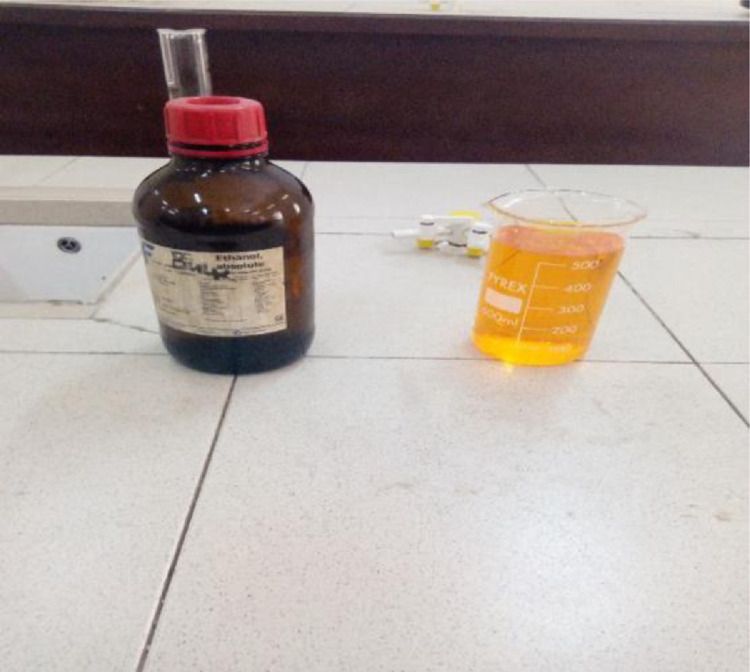
liquefied Kr2Cr2O7 and ethanol.